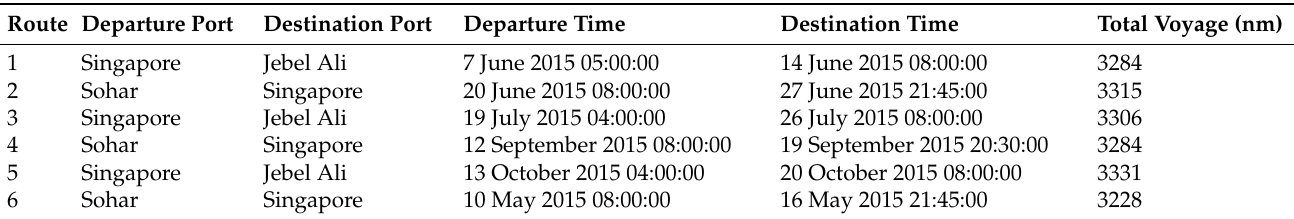
Table 4. Basic information of each